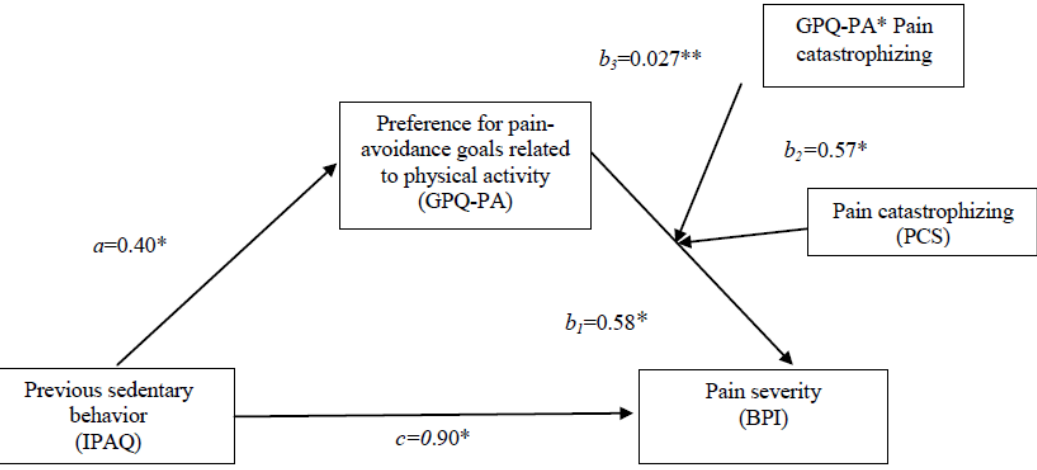
Figure 3. The moderated-mediation model showing the standardized analysis of previous seden- tary behavior on pain through the preference for pain-avoidance goals and moderated by pain catastrophizing (model 14). Note: * p < 0.05; ** p <